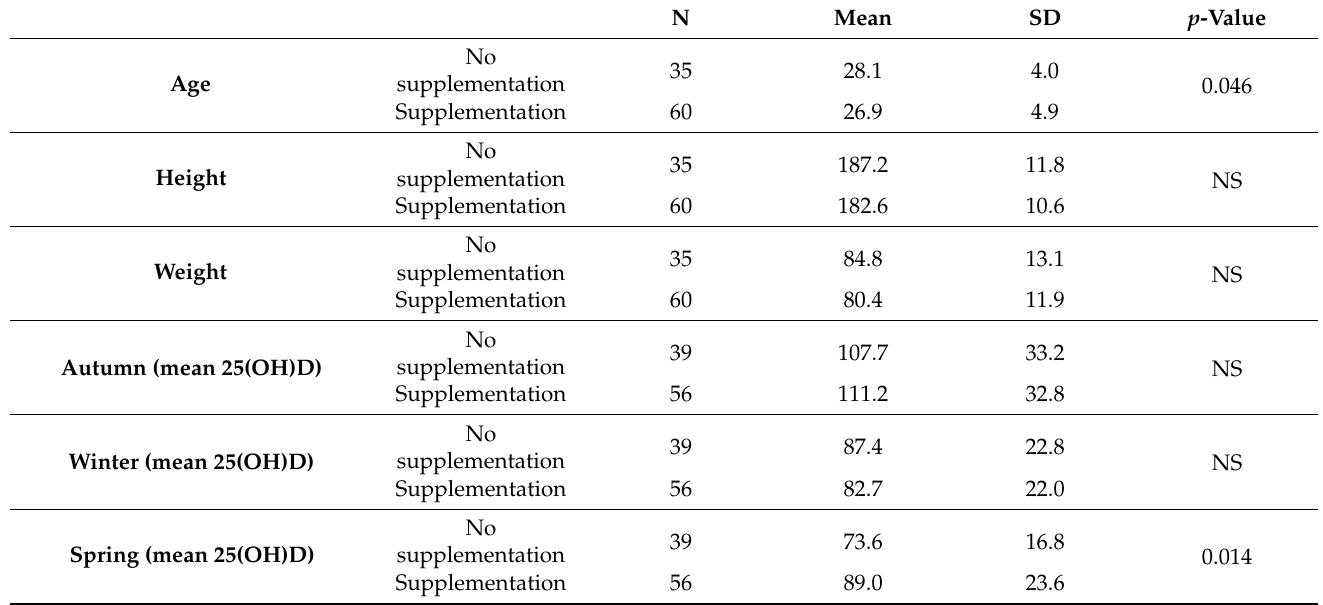
Figure 2. Differences in mean 25(OH)D concentrations (nmol/L) by season. Significant differences were set up as follows ( a p < 0.05 and b p < 0.01). The highest rate of vitamin D insufficiency (<75 nmol/L) was found in spring (40% of the team players), followed by winter (35%), and autumn (10%). Spring vitamin D concentrations were significantly and positively related to supplementation. In fact, sup- plemented players had significantly higher vitamin D concentrations during springtime (Table 2). Although not significant, supplemented players presented also lower weight. Table 2. T-test between age, weight, height, and 25(OH)D concentrations (nmol/L) according to